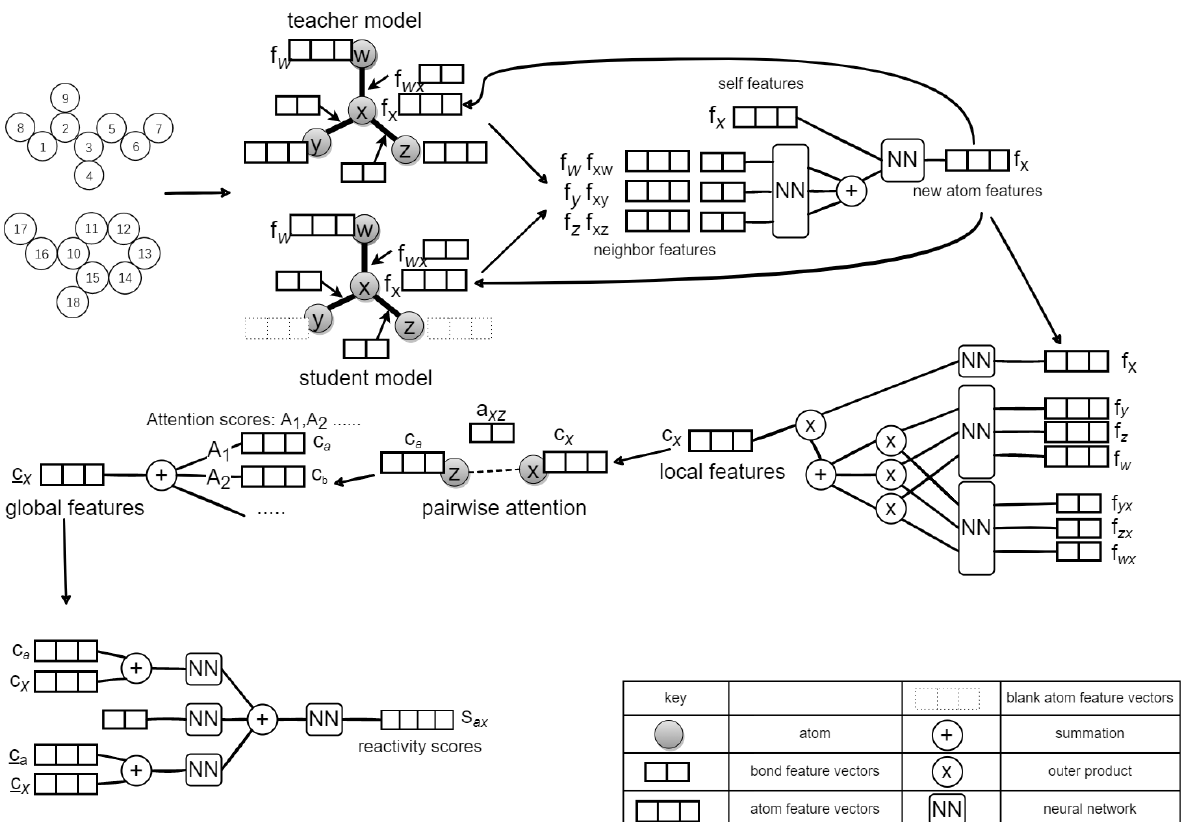
Figure 5. The workflow of the Mean Teacher Weisfeiler–Lehman Network (MT-WLN) for predicting reaction